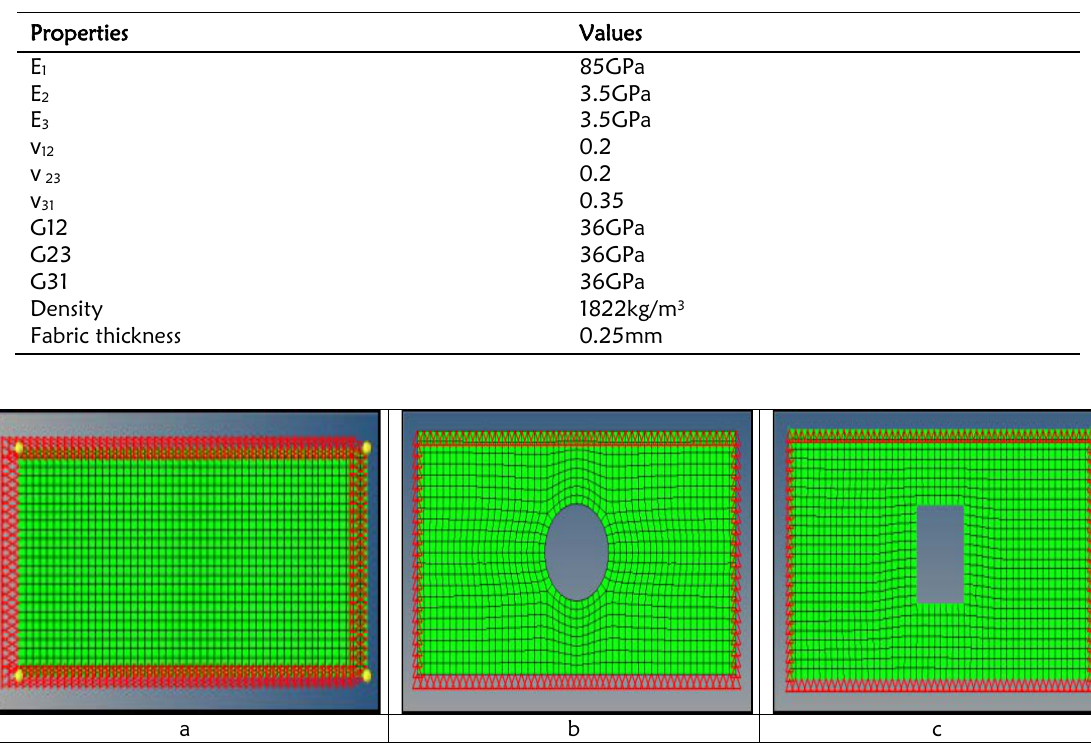
Figure 5: CCCC boundary configuration of (a) bare plate, (b) plate with circular hole and (c) plate with rectangular